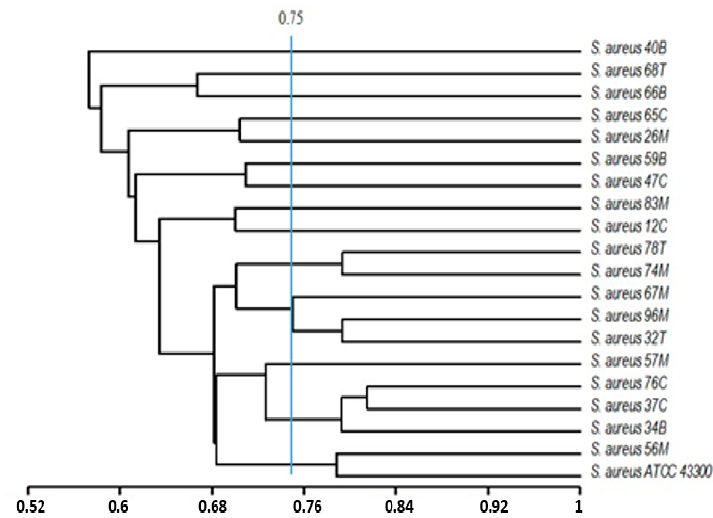
Figure 5. Dendrogram based on the unweighted pair group method of arithmetic averages and Jaccard’s correlation coe ffi cient based on the phenotypic and genetic traits of the S. aureus population. Numbers on the horizontal axis indicate the percentage of similarity.